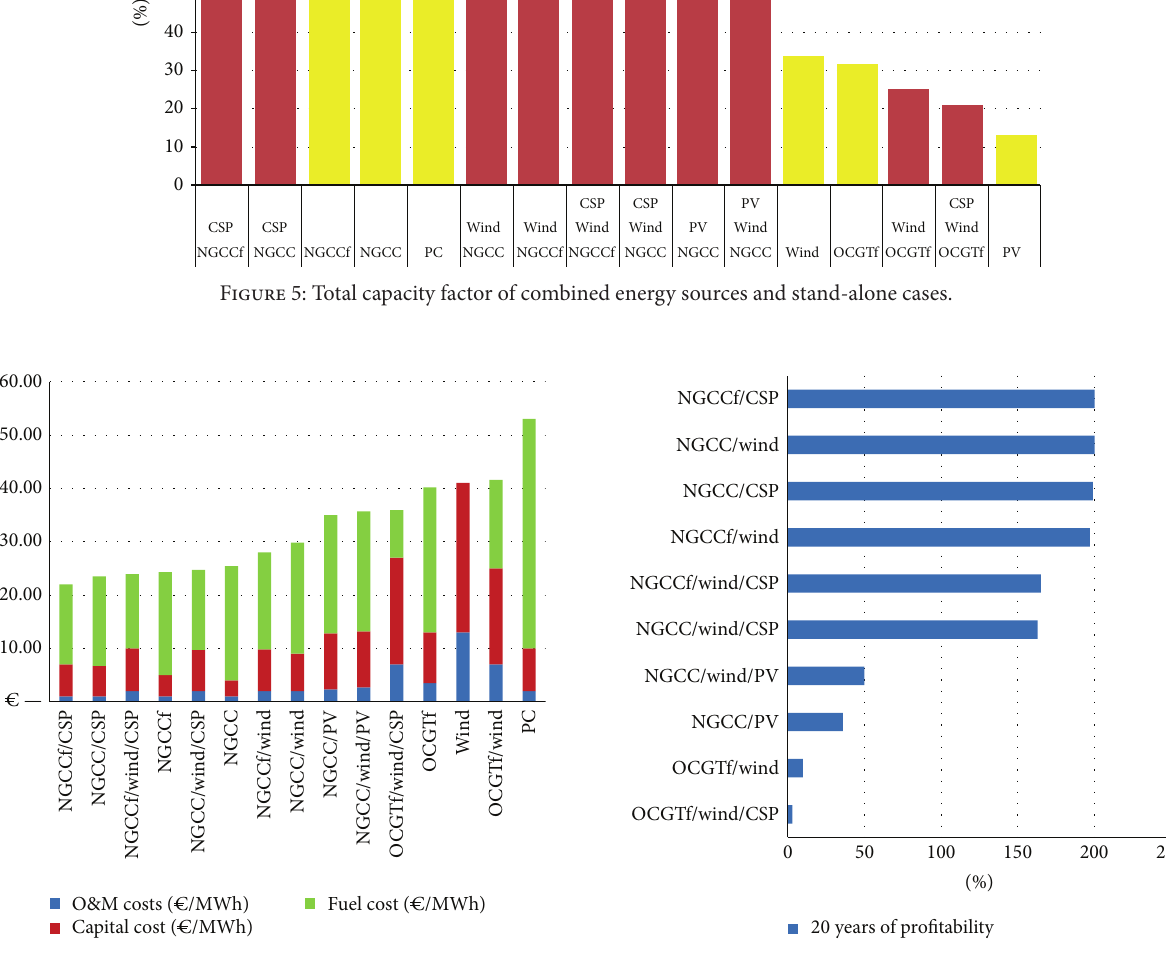
of the interactions between all the variables, both among the various factors and between the factors and indicators. 2.5.1. Interdependency Mapping. The map seen in Figure 8 shows the interactions between the input factors (white/blue and blue) derived from the first stage of analysis, and the energy and economic indicators (red). The connecting lines and symbols “+” and “ − ” indicate proportional direct positive and negative influence between the factors, while the green lines show the relative analytical formulae. From the map we observe that the dominant factor is the energy share, which, limited by its partial efficiency (formula % 𝐸 max ), is in turn directly linked to the profitability of the particular combined energy sources. Thus beginning from very limited initial data, in a few steps we can optimize the influences on the